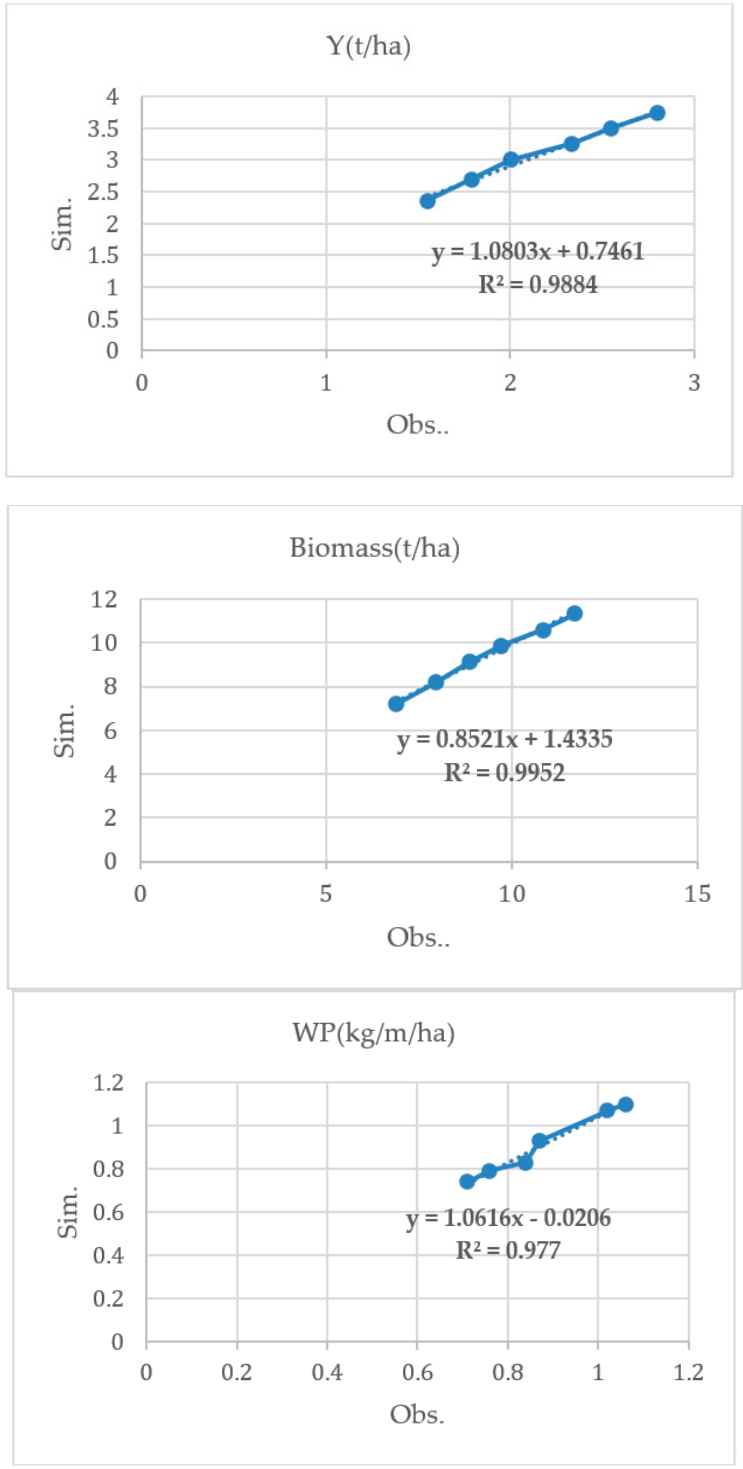
Figure 3. The results of model calibration for simulating grain yield, biomass, and water use efficiency for the barley crop under different irrigation conditions. for the barley crop under different irrigation